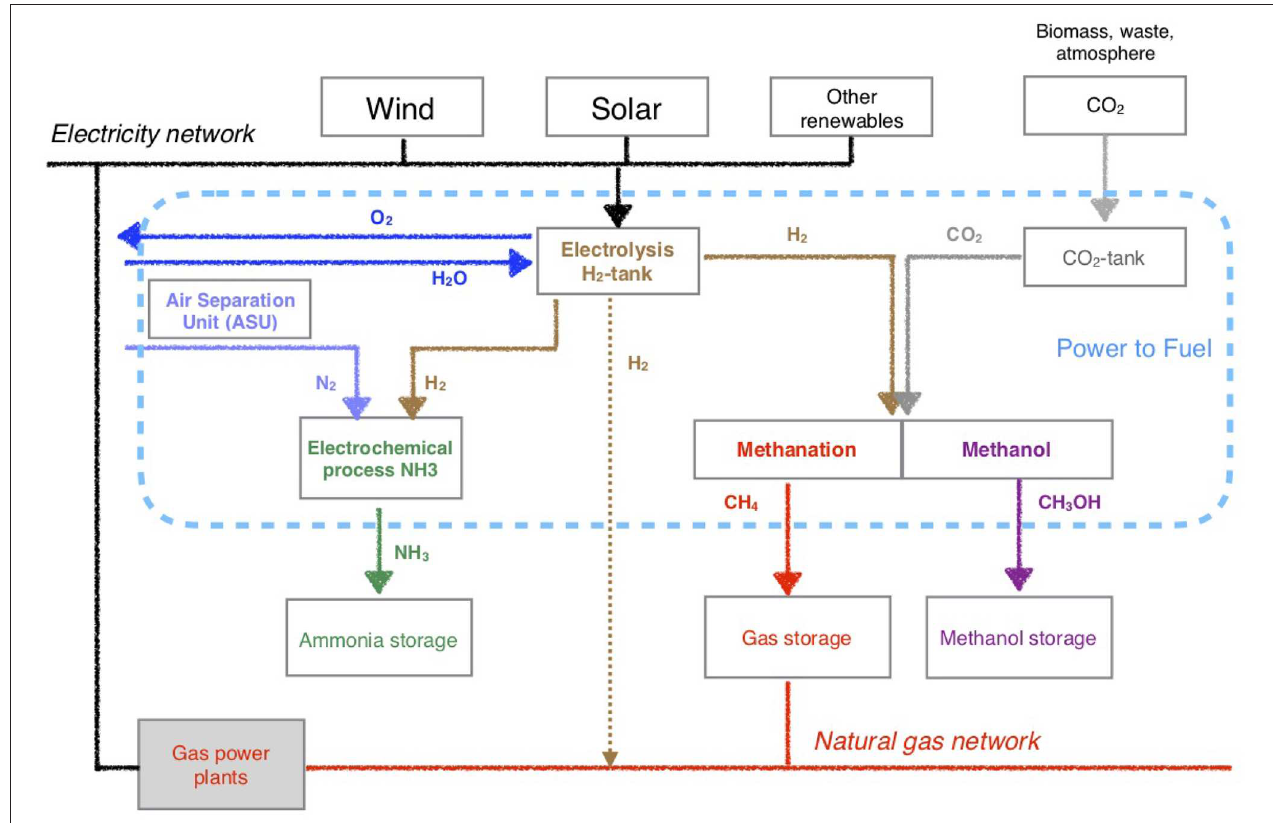
FIGURE 4 | Schematic pathway of Power-to-Fuel: production of H 2 , NH 3 , CH 4 , and CH 3 OH from renewable resources; and integration to gas and electrical